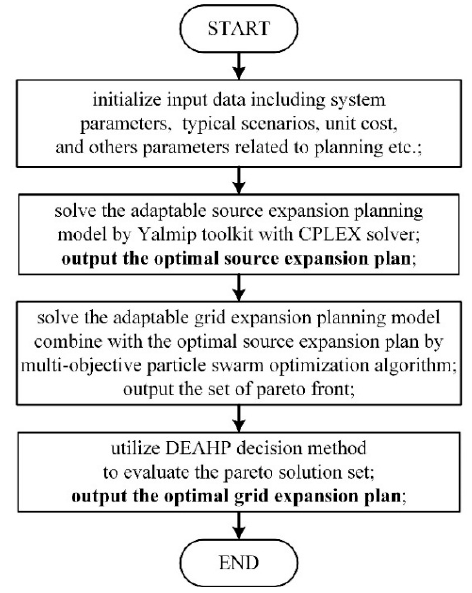
Figure 3. Flow chart of grid-generator coordination planning.